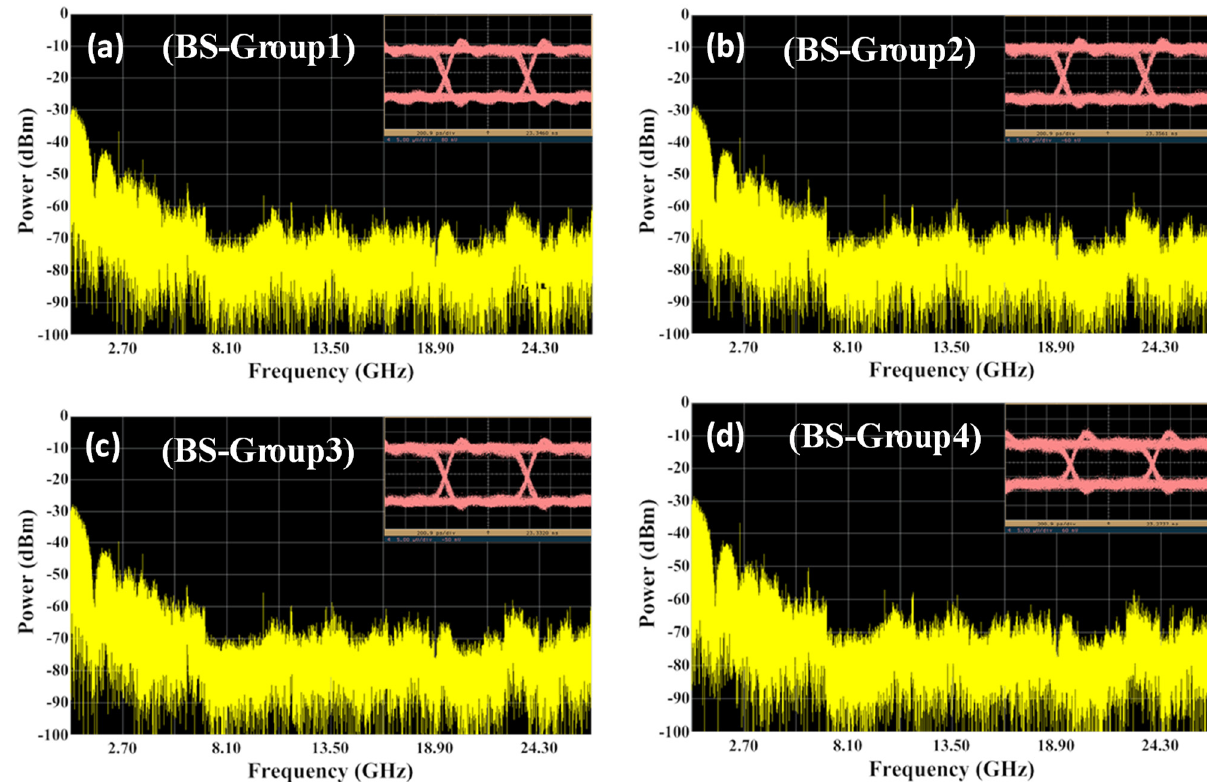
Figure 6. Electro-spectrum and eye diagram of frequency down-converted uplink RoF signals received at the CO end of